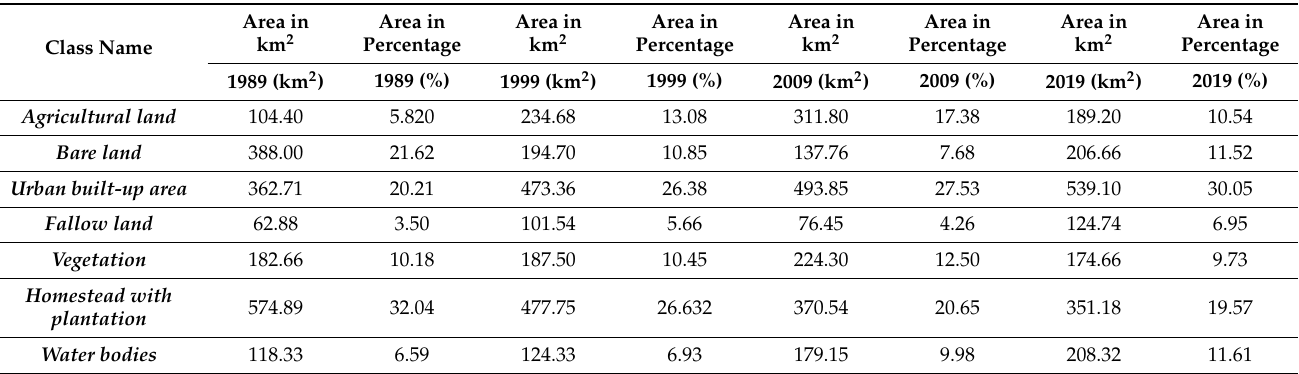
Table 6. Temporal areal account on LULC